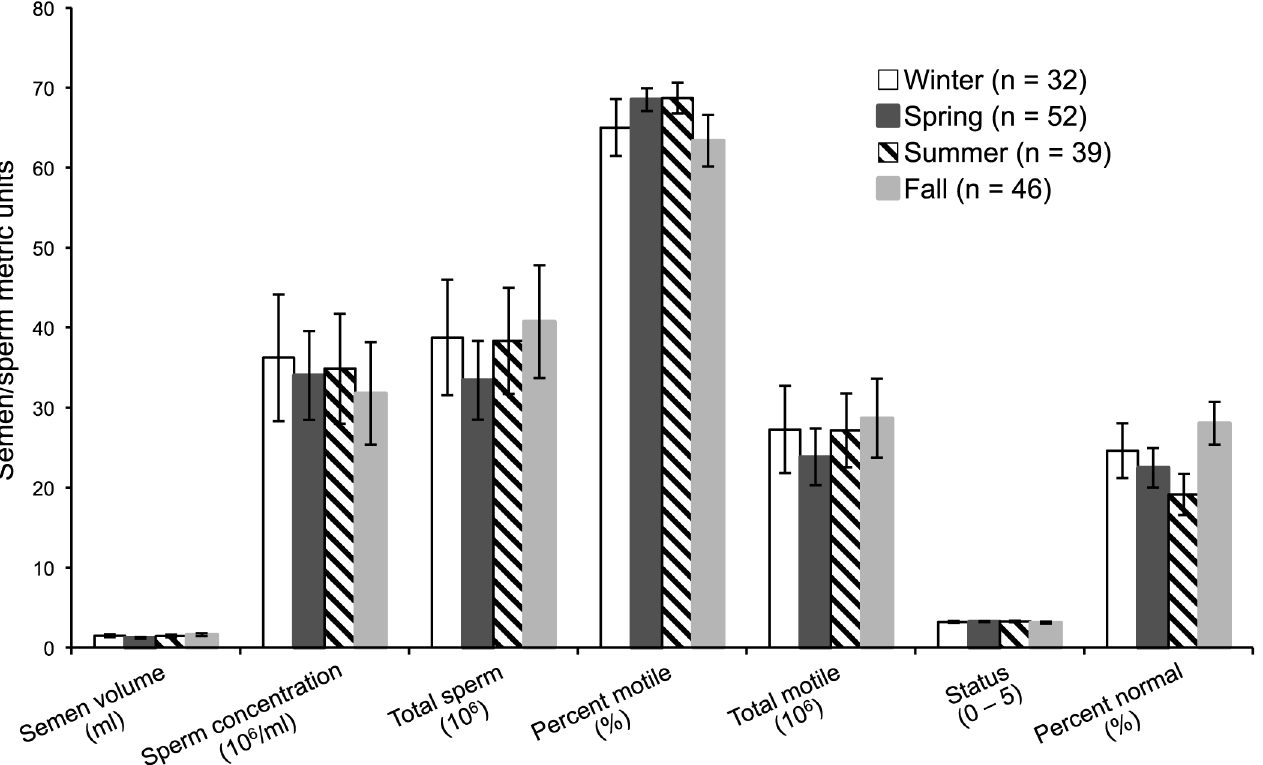
Fig 1. Mean ( ± SEM) seasonal ejaculate traits from cheetahs where semen was collected in different seasons at institutions throughout the USA (169 total ejaculates; number/season indicated in parentheses). There were no differences ( P > 0.05) in any trait across seasons.